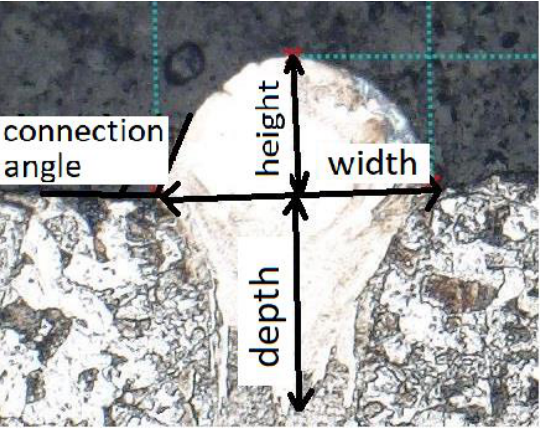
Figure 4. Observed parameters on the single track in this experiment (similar to [2]).